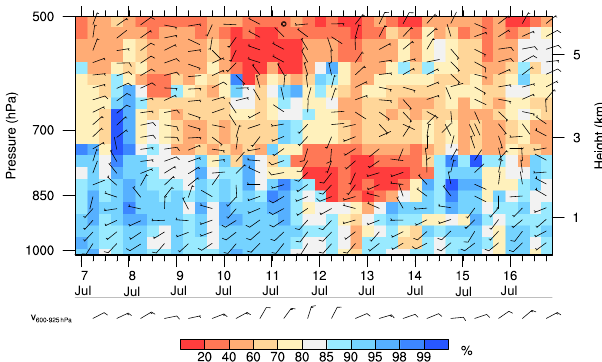
Figure 15. Vertical structure of the atmosphere during part of Phase 2. Shown are relative humidity (shading according to scale, four times daily), wind (barbs) and 600–925hPa vertical wind shear (below main plot) (both two times daily) from radiosondes launched at Abidjan (for location see Fig. 1) during 7–16 July